Question: Give a one-sentence summary of this figure.
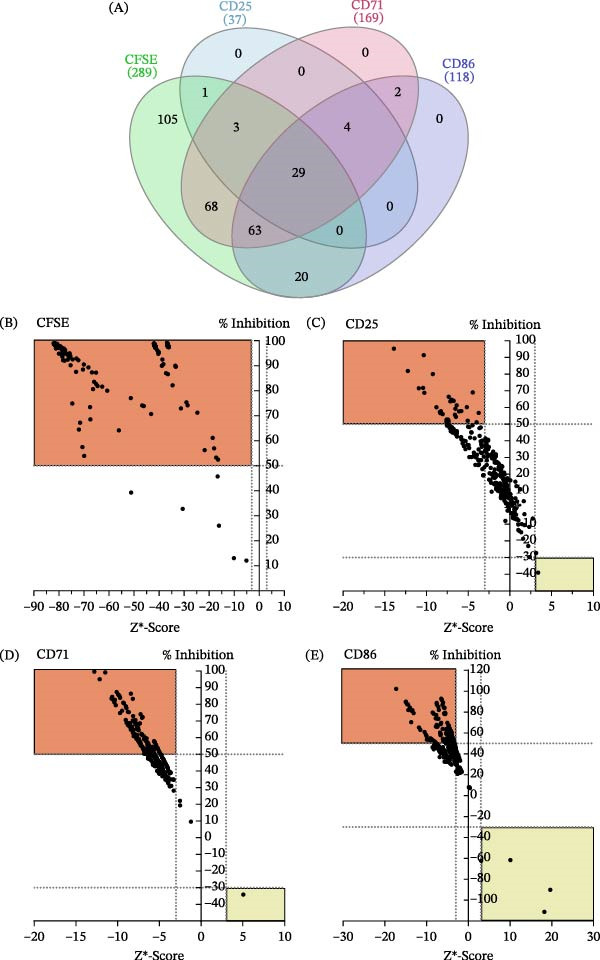
Answer: Identification and overlap of T‐cell modulatory compounds from pilot screen across multiple activation markers. (A) Venn diagram illustrating the overlap of identified hits across the four markers. Scatter plots (B: CFSE, C: CD25, D: CD71, and E: CD86) showing percentage inhibition versus ‐score for each activation marker. The dotted lines represent the cutoff points for hit selection. Compounds were defined as potential hits if they showed a percentage inhibition of ≥ +50% (inhibitors) or ≤ −30% (activators) and had a ‐score < −3 or > +3 (gray boxes). Inhibitory effects are highlighted in orange, whereas activating effects are shown in yellow for the respective marker readouts. Each compound was tested at a single concentration in two independent screening runs, and the median value of both experiments was used for hit identification.